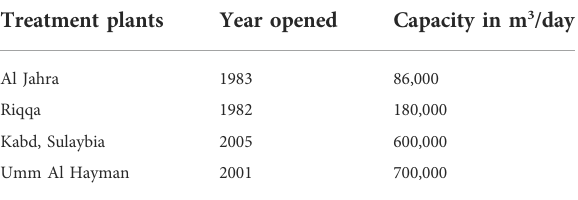
TABLE 3 Details of wastewater treatment plants in Kuwait (Al-Shammari, 2018; Abusam et al., 2012; MEED, 2022). Treatment